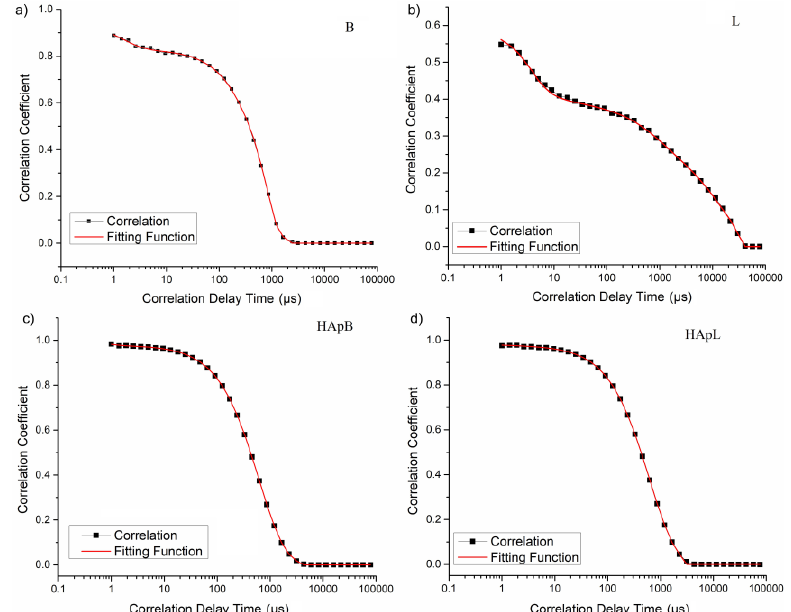
Figure 3. Experimental (markers) and fitted (red line) autocorrelation function obtained with DLS experiments for B ( a ); L ( b ); HApB ( c ) and HApL ( d ) samples.